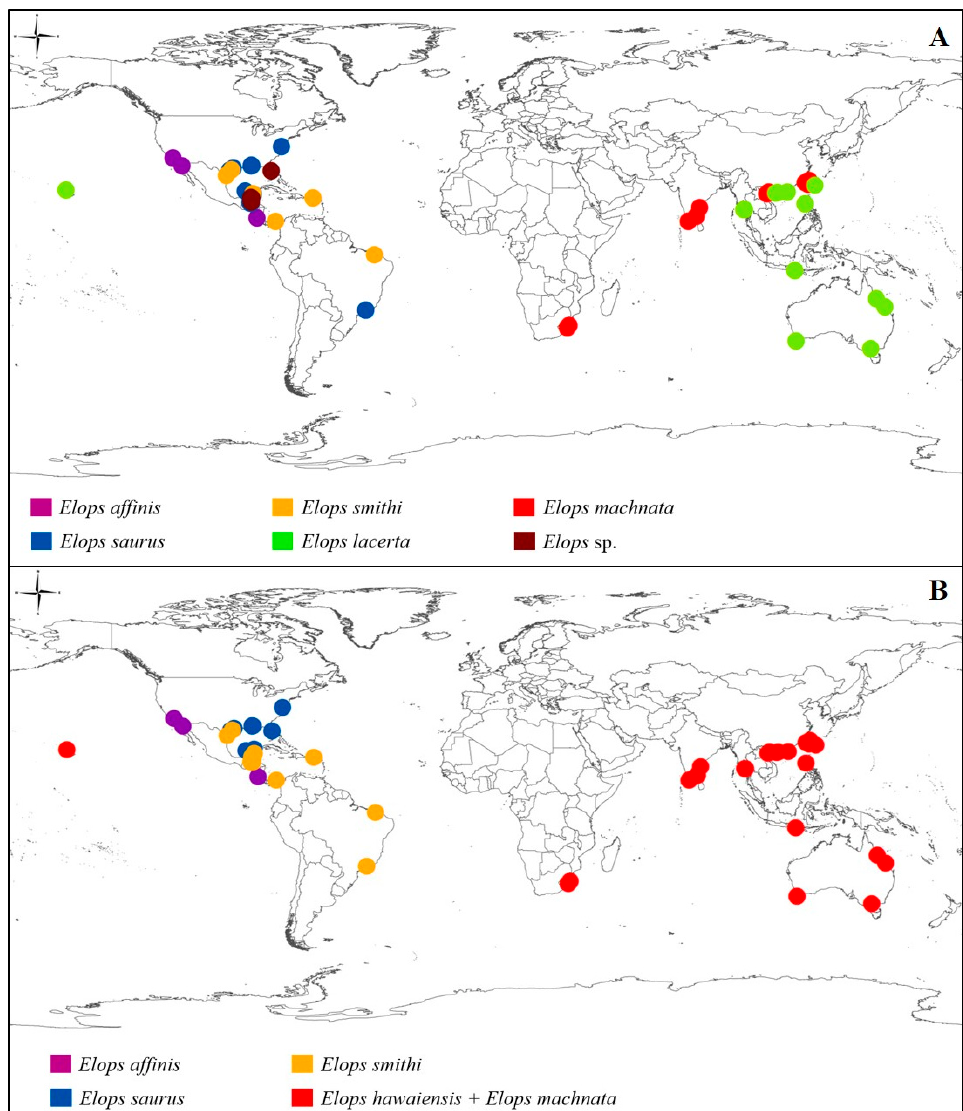
Figure 3. Geographical origin of the sequences of the species used in this study. ( A ) According to the taxonomic description of the databases. ( B ) According to the phylogenetic relationships.